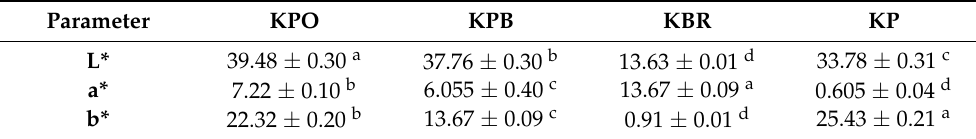
Table 3. Color parameters of freeze-dried powders.